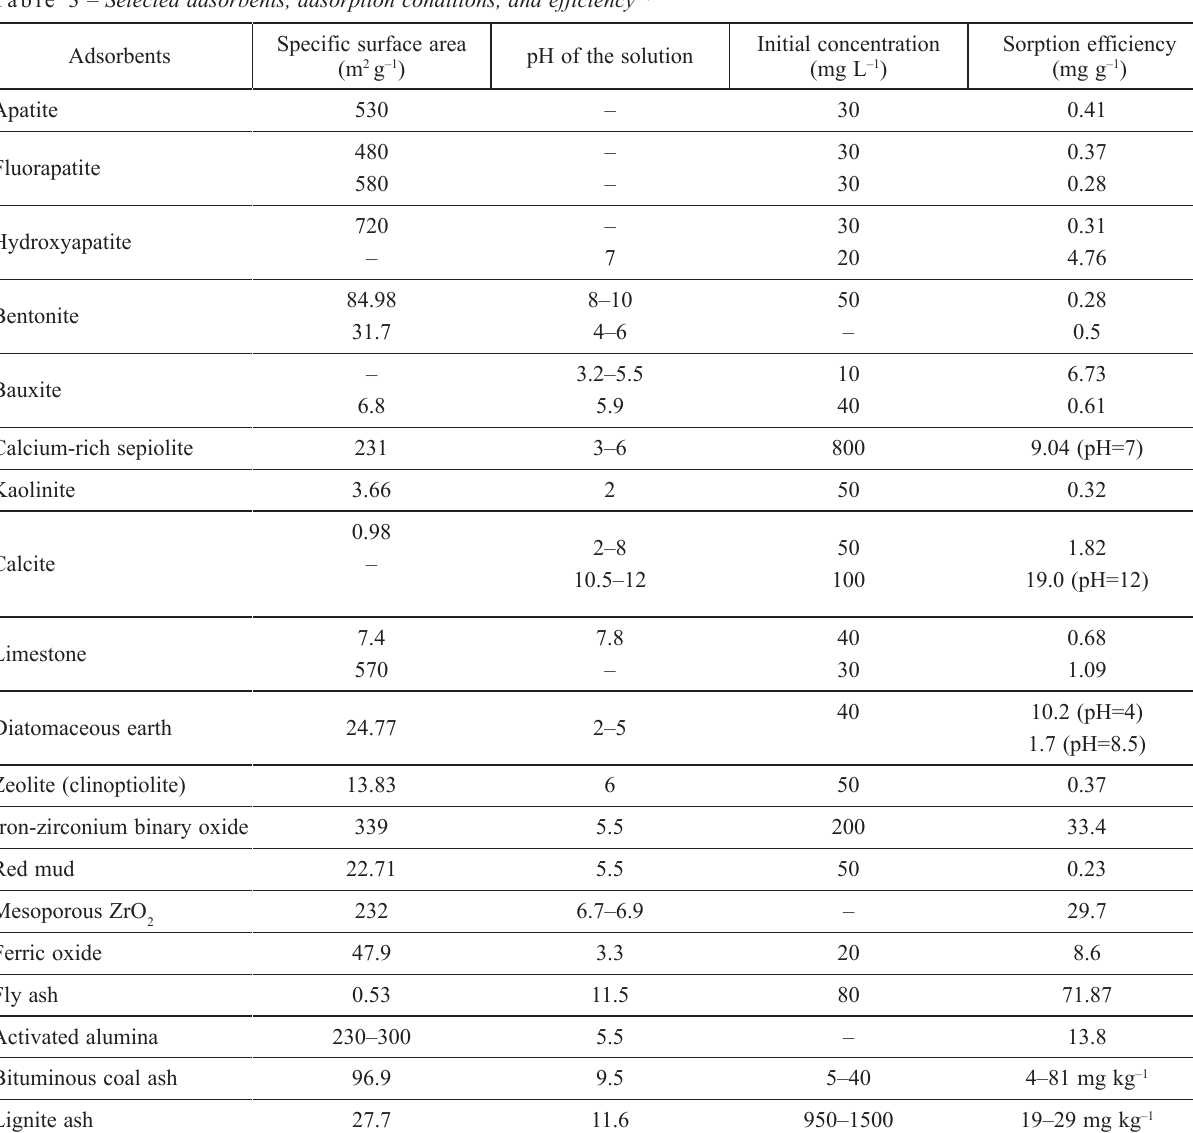
Table 3 – Selected adsorbents, adsorption conditions, and efficiency 89,138